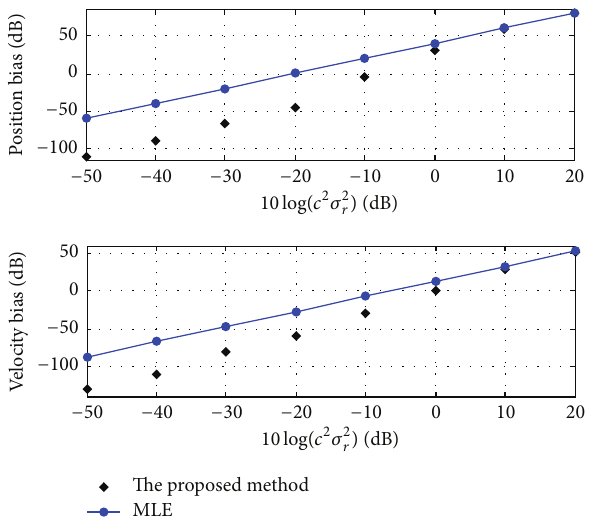
Figure 7: Comparison of root mean square error (RMSE) of the proposed method with the original MLE, Taylor-series method, and the CRLB for far-field source. The accuracy is shown in log scale as the noise power